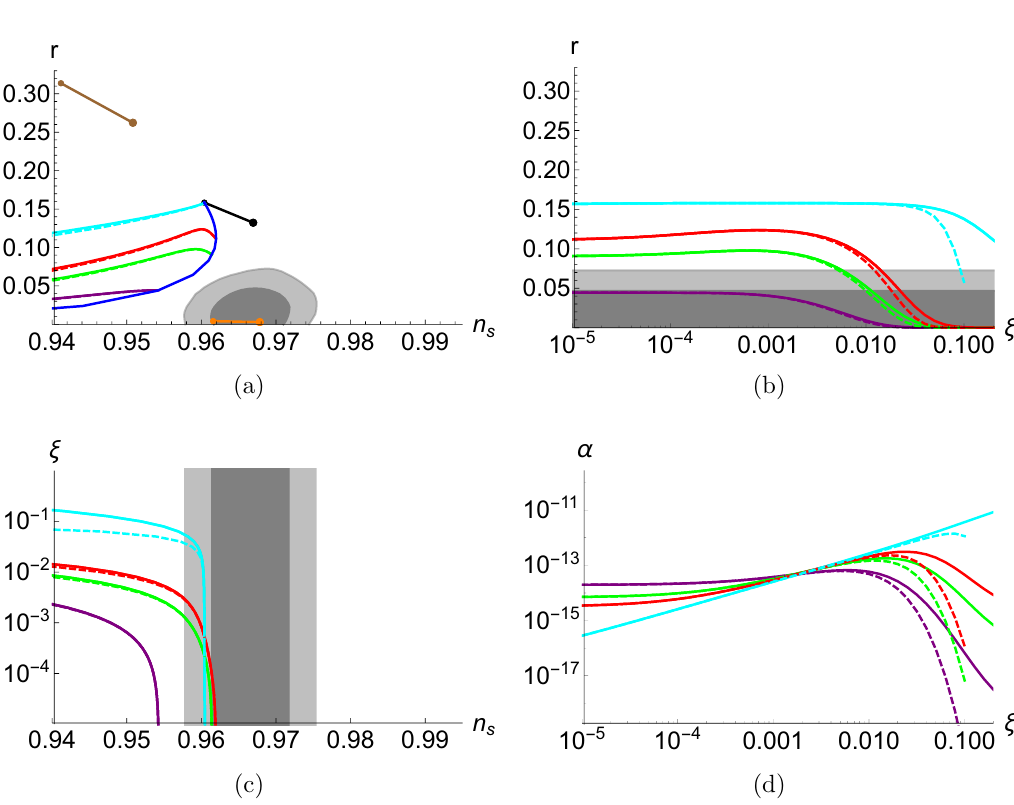
Figure 7. r vs. n s (a), r vs. ξ (b), ξ vs. n s (c) and α vs. ξ (d) for δ = 40 , 70 , 100 , 1000 respectively in purple, green, red and cyan with N e = 50 e -folds in region 2. Continuous/dashed line represents metric/Palatini gravity. For reference we plot the predictions of CW inflation for N e = 50 (blue), R 2 (orange), χ 2 (black) and χ 4 (brown) inflation for N e ∈ [50 , 60] . The gray areas represent the 1,2 σ allowed regions from Planck 2018 data [6].